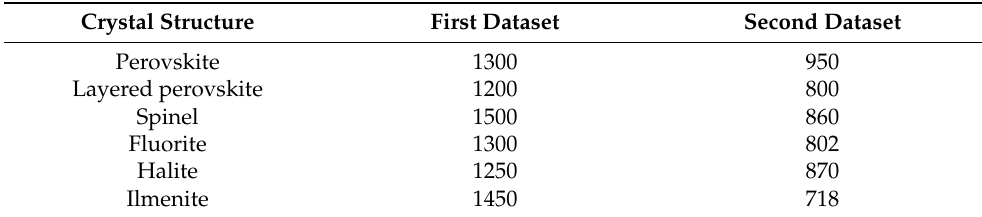
Table 2. The distribution of the